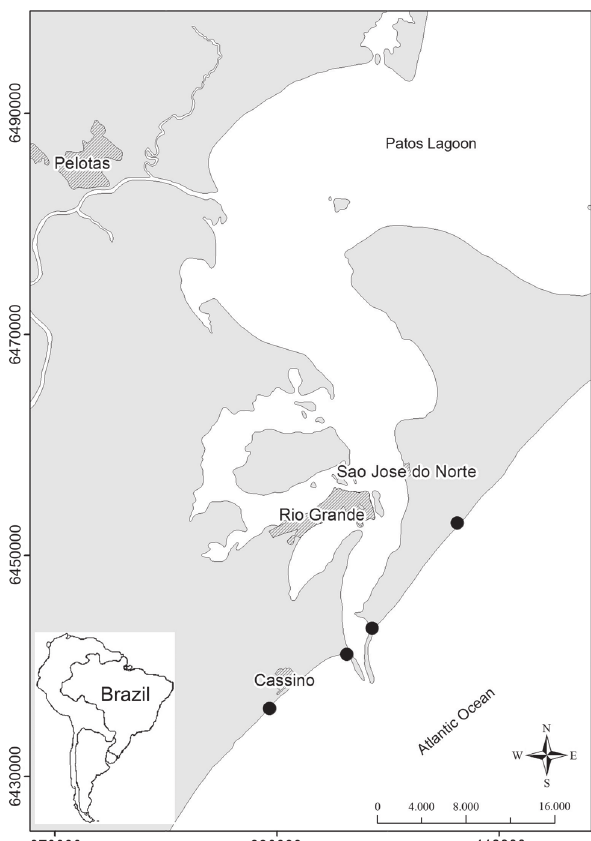
Figure 1. Map of the study area. Black circles show the sampling